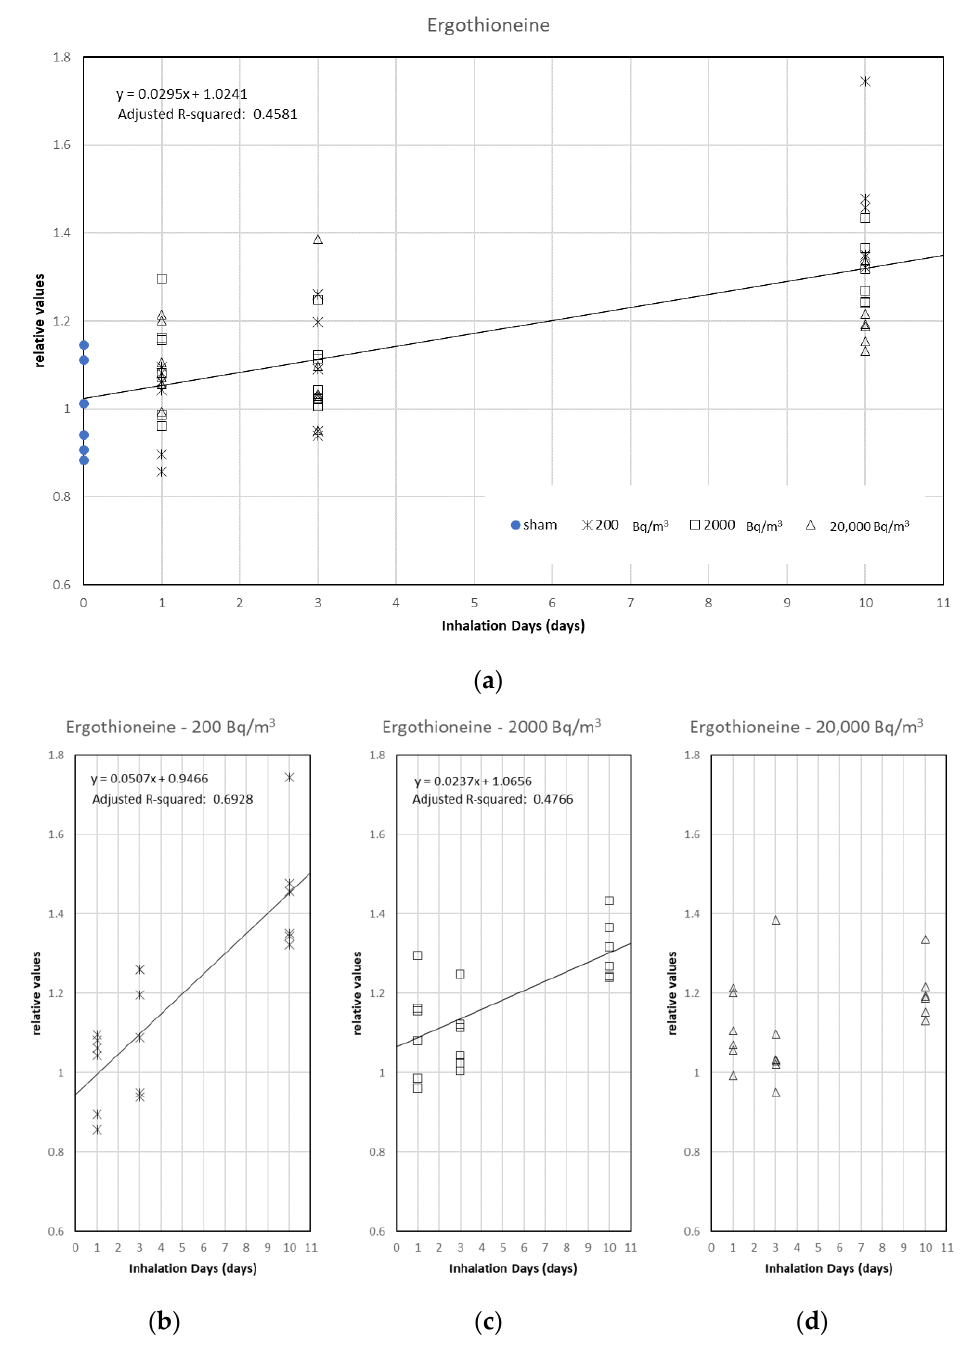
Figure 5. Scatter plots between inhalation days and Ergothioneine with a simple linear regression. The results are shown for ( a ) all groups, ( b ) 200 Bq/m 3 groups, ( c ) 2000 Bq/m 3 groups, and ( d ) 20,000 Bq/m 3 groups (without a regression line because the results were not statistically significant).